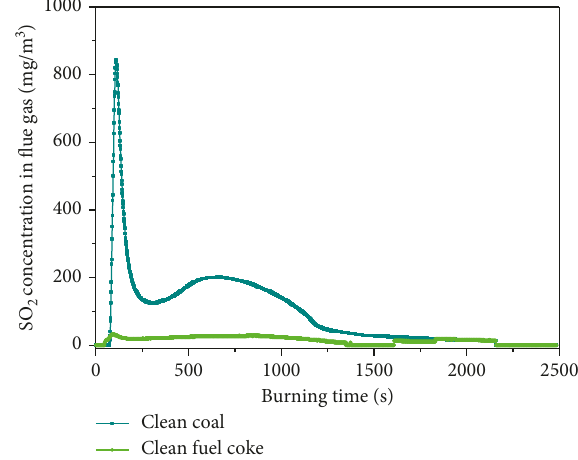
Figure 3: SO 2 emissions during combustion for clean coal and clean